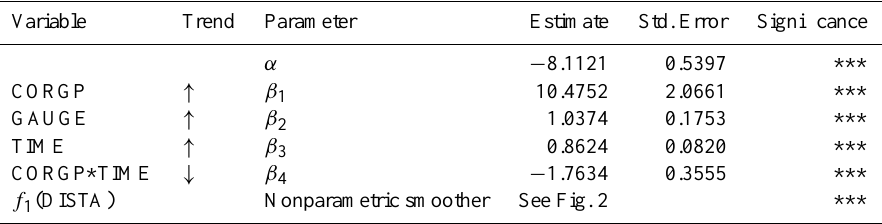
Table 4. Parameter estimates and significances for the model estimating the portion of rill cells (RILLR) as shown in Eq. (8). Significance of linear predictor variables’ significant influences. ↑ , ↓ : RILLR increases (decreases) with increasing values of the respective predictor variable.